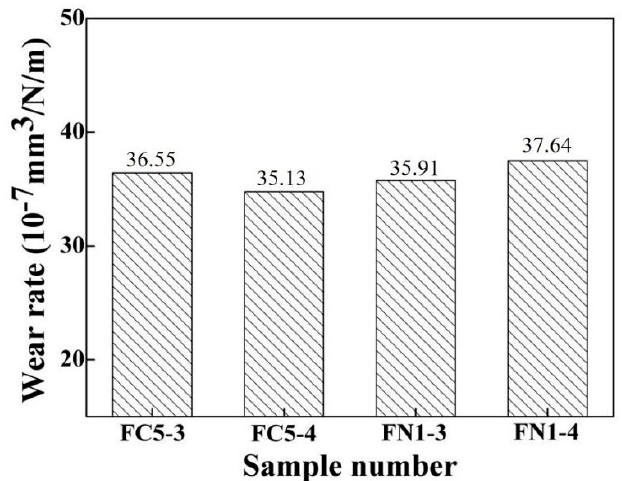
Figure 10. Wear rate of four coated carbides.